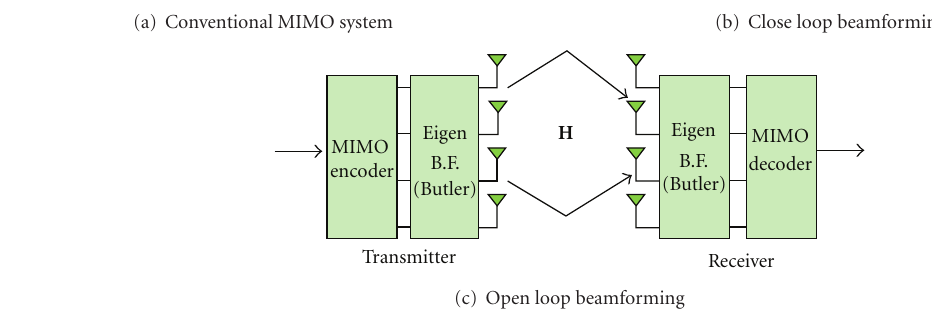
Figure 1: System